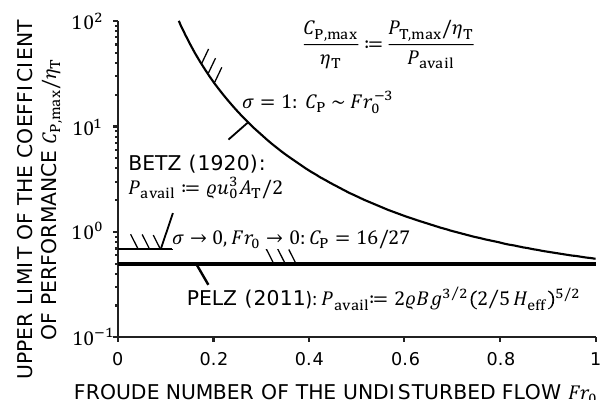
Fig. 5. Upper limit of the coefficient of performance versus Froude √ gh 0 . The thick line number of the undisturbed flow Fr 0 = u 0 / shows C P as defined by Pelz (2011). The coefficient of performance is independent of the Froude number and has a constant upper limit, whereas there is no Betz-limit for σ > 0 (adapted from